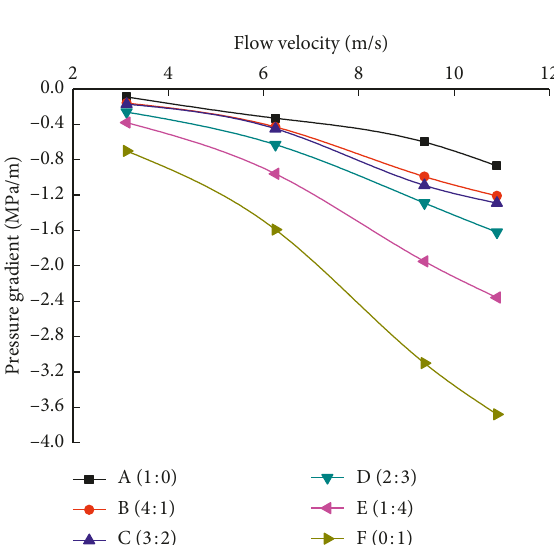
Figure 5: Flow velocity and corresponding pressure gradient of specimen A (1 :0) under different axial displacements ( S ).